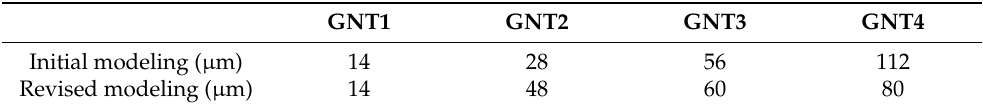
Figure 3. ( a ) the true stress-true strain relation of the GNT samples is calculated according to the ultimate stress in experiment. ( b ) The volume fraction of the transition zone as a function of yield strength gradient with constant height (linear increase) and revised height (non-linear increase). Experimental data come from [5]. Table 2. The total height of transition zone in the GNT samples of the original and the revised modeling, respectively.